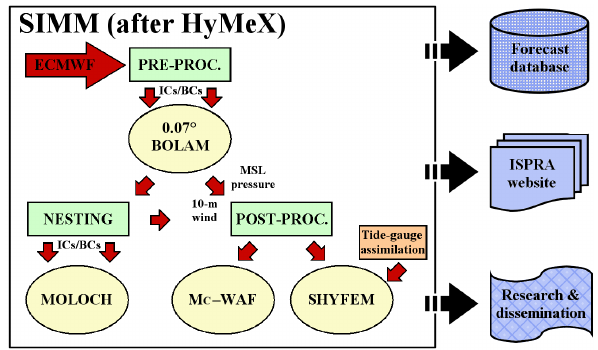
Figure 4. As in Fig. 1, but for the SIMM configuration (not yet op- erational) designed for the HyMeX campaigns. This configuration includes the BOLAM meteorological model nested at 0.07 ◦ , with a 0.25 ◦ ECMWF forcing, the 0.0225 ◦ MOLOCH forced by BO- LAM, the Mc-WAF wave modelling suite forced by BOLAM and MOLOCH, and the low- and high-resolution SHYFEM sea surge model forced by BOLAM, with and without a tide-gauge assimila- tion